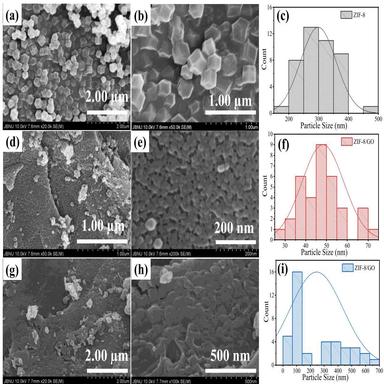
FESEM images at low and high resolutions along with particle size distribution plots for (a-c) ZIF-8 crystals, (d-f) ZIF-8/rGO and (g-i) ZIF-8/GO composites, respectively.